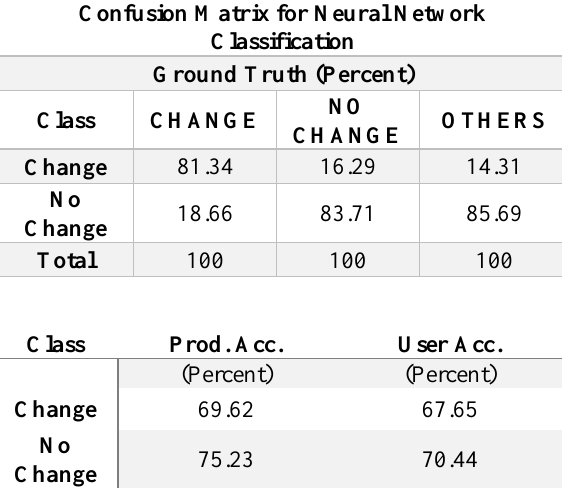
Table 3. Confusion Matrix for Neural.Network